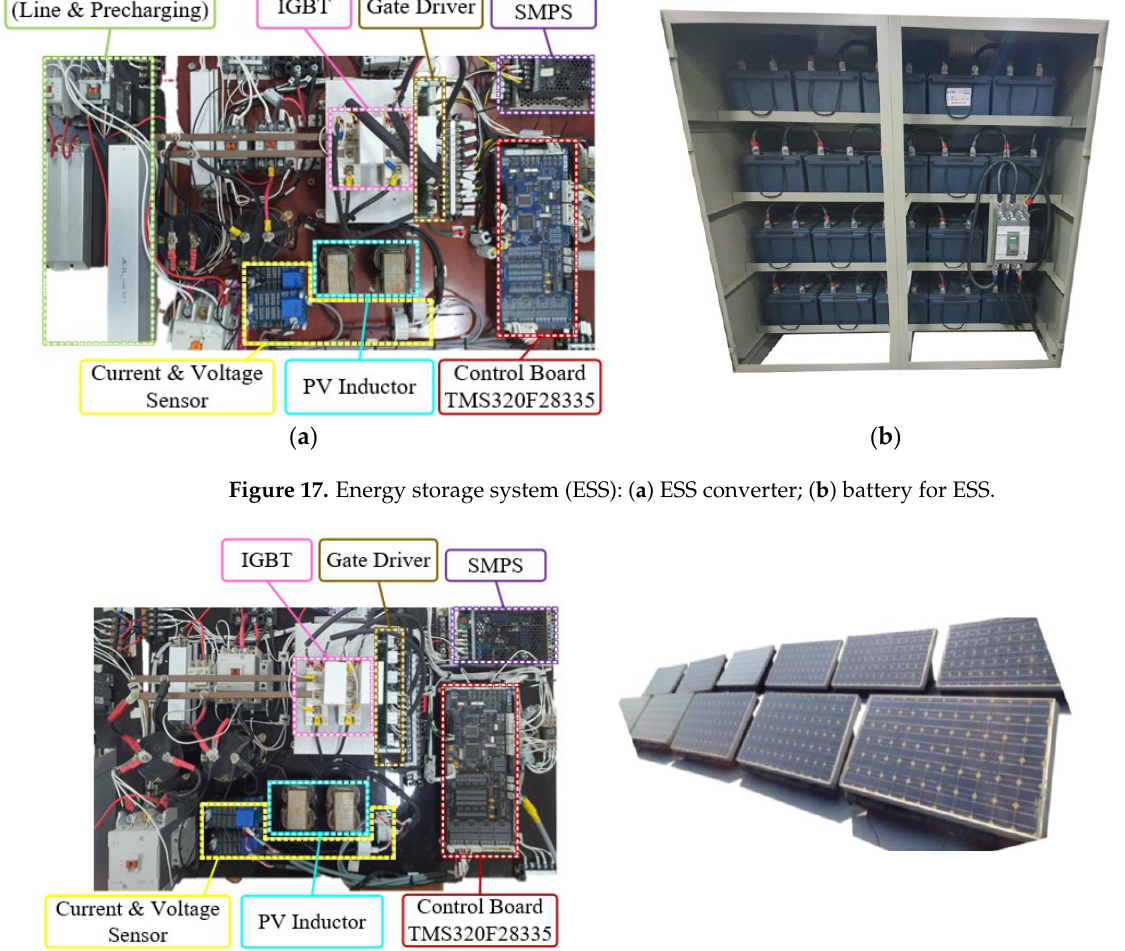
Figure 18. Photovoltaic (PV) generation system: ( a ) PV converter; ( b ) PV panels.